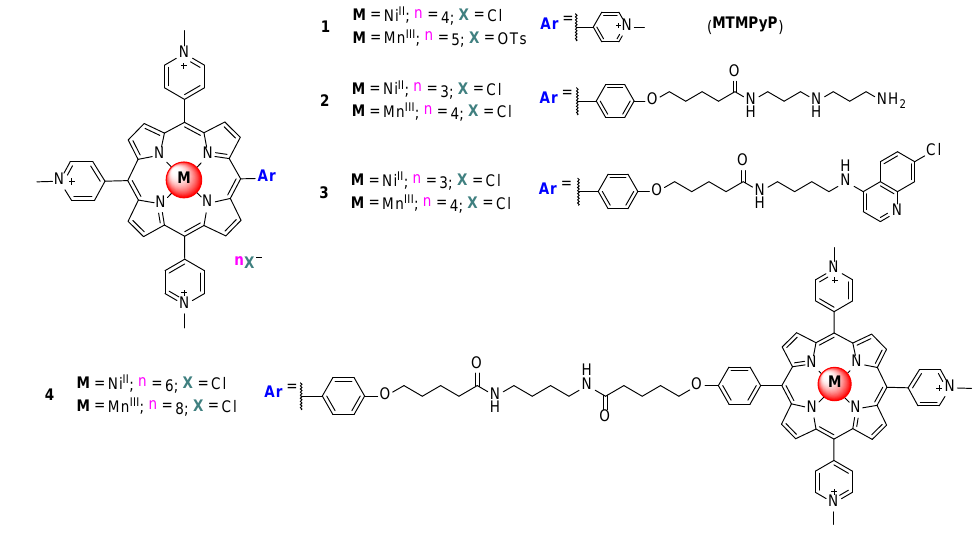
Figure 10. Structure of the Ni II and Mn III porphyrins derivatives studied by Dixon et al. [71]. The kinetic constants for the association and dissociation of different porphyrins with duplex and quadruplex DNA were obtained and depending on the kinetic mode (slow or fast) different types of interaction were